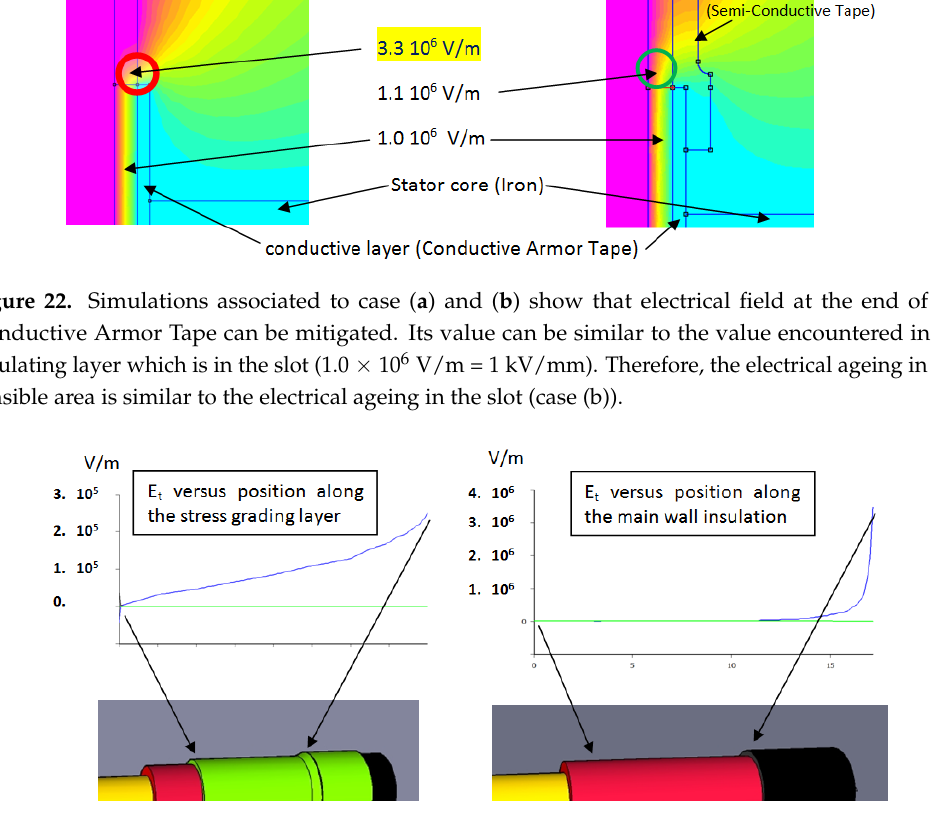
Figure 23. Two cases, one with stress-grading and one without stress-grading are simulated. The tangential electrical field (E t ) along the main wall insulation is plot. With stress-grading, the tangential electrical field is under 3.10 5 V/m (300 V/mm). Without stress-grading the tangential electrical field can reach 4.10 6 V/m (4000 V/mm).